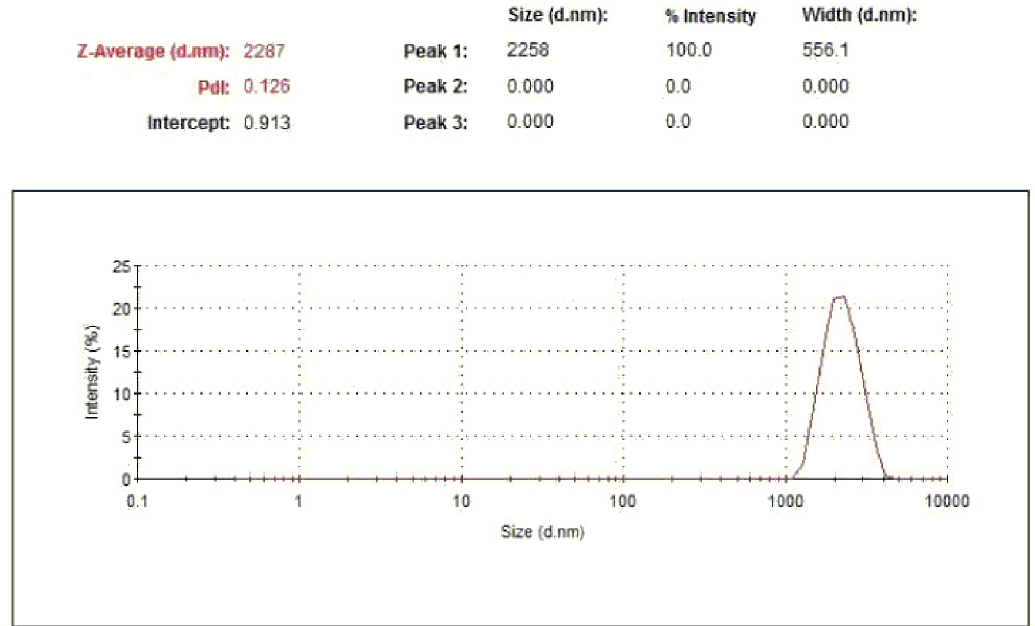
Fig 10. Particle size distribution of 7e-loaded PLGA microspheres.